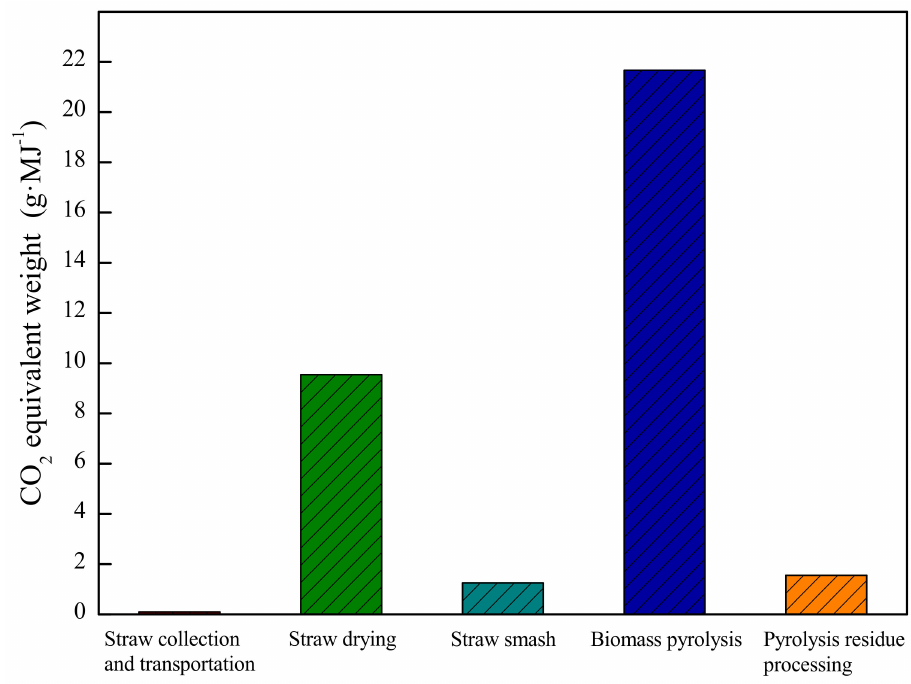
Figure 9. Distribution of CO 2 equivalent emission in each step of the non-phase-transition drying pyrolysis and mass conversion